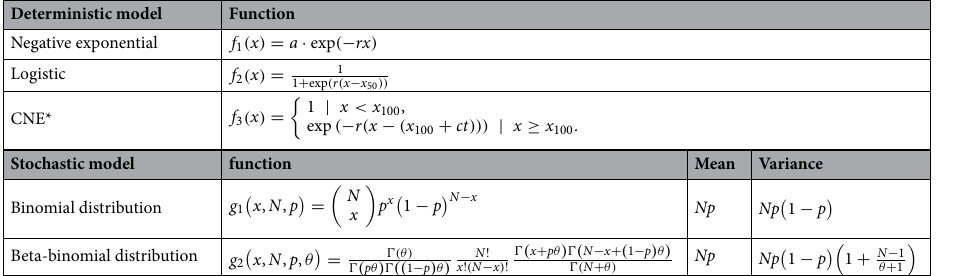
Table 1. Deterministic and stochastic models used for fitting all combinations of deterministic and stochastic models. Parameters are described in the “Materials and methods” section. CNE constrained negative